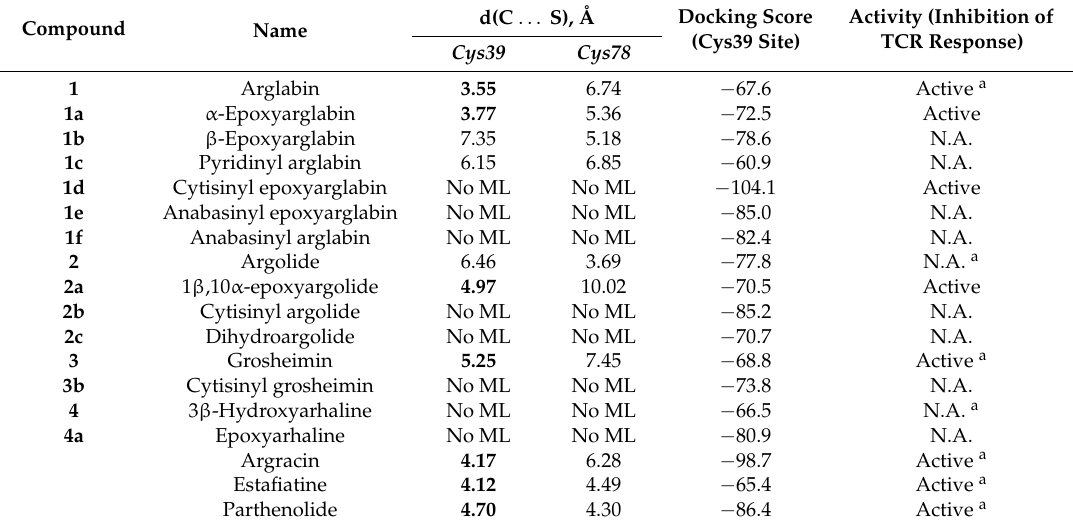
Table 2. Distances between the S–H bond in the cysteine residues of the ZAP-70 tandem-SH2 module and the exocyclic double bond of the lactone ring in the SLs predicted by molecular docking.